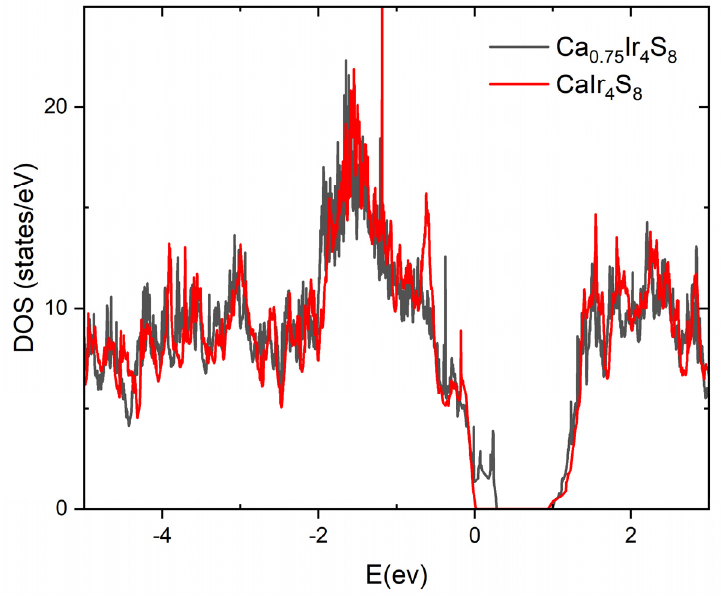
Figure 9. Comparison of DOS in Ca 0.75 Ir 4 S 8 and the stochiometric compound.